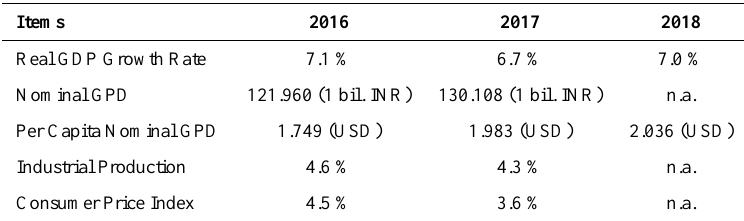
Table 1. India’s Economic Indicators.